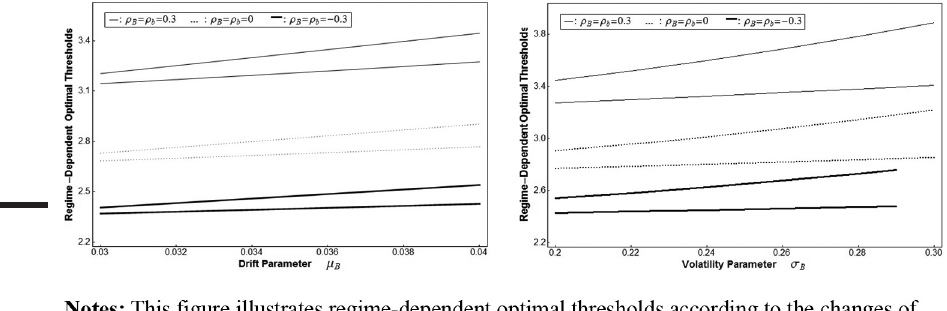
Figure 1. Regime-dependent optimal thresholds (symmetric